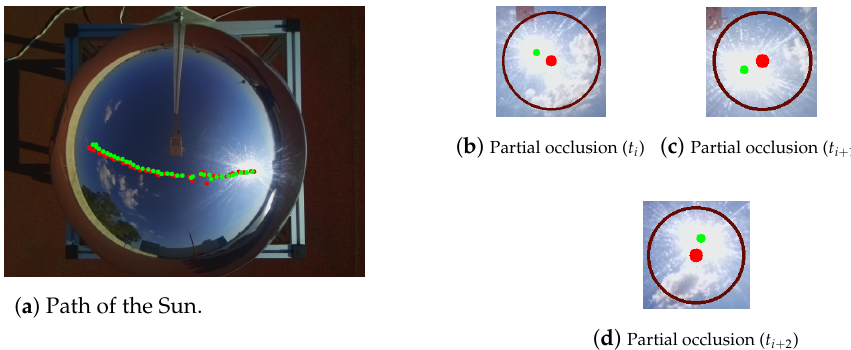
Figure 16. Path followed by the Sun (Set 2). In ( b – d ), partial occlusion of the Sun are